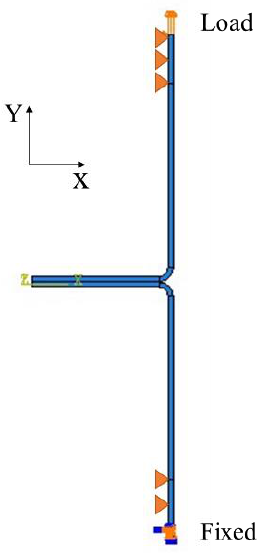
Figure 6. Finite element (FE) model of the specimen and boundary conditions.